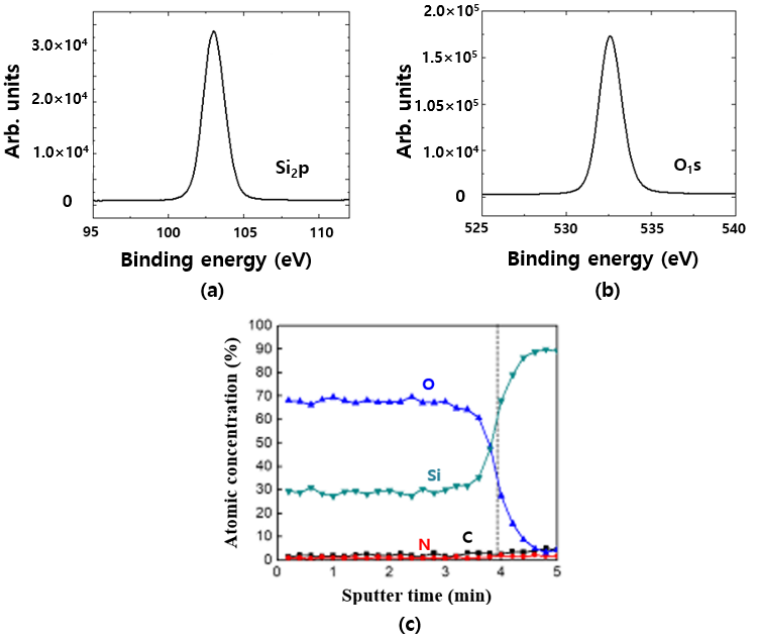
Figure 5. XPS spectra of SiO 2 are also shown: ( a ) Si 2 p and ( b ) O 1 s. ( c ) Deposited thin-film composition analysis.